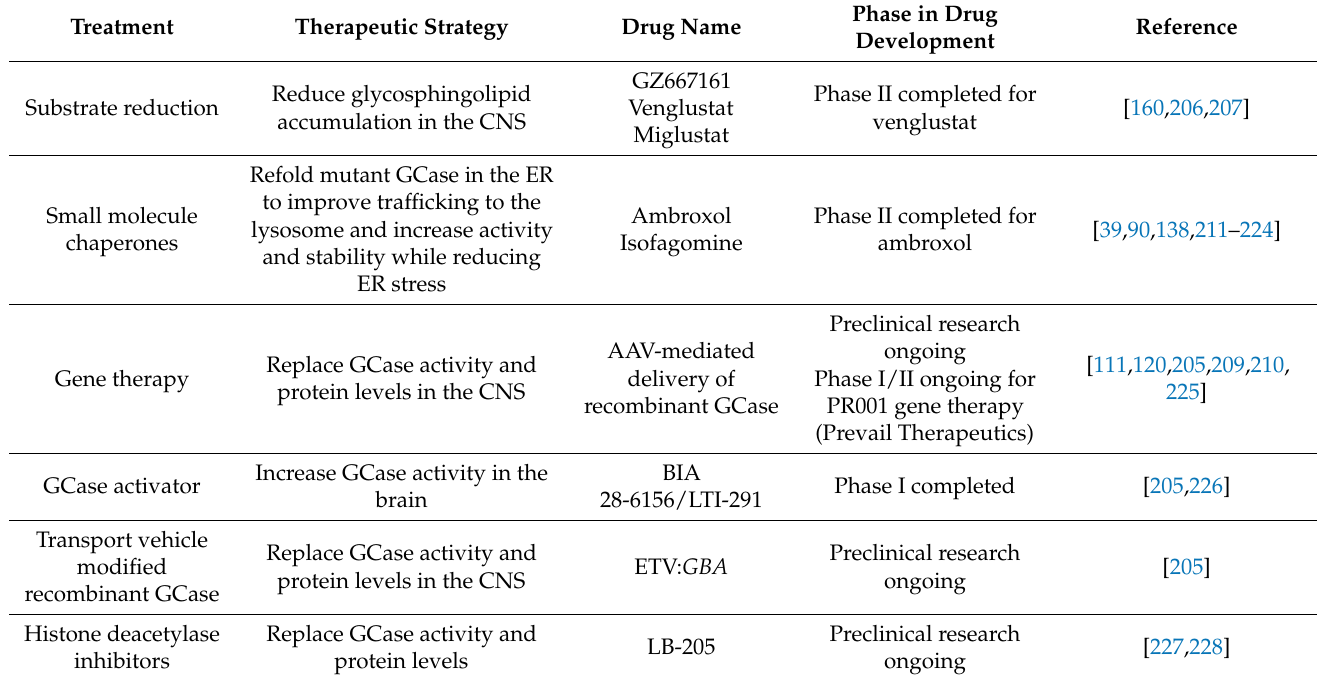
Table 2. Potential therapies to target GCase to treat GBA